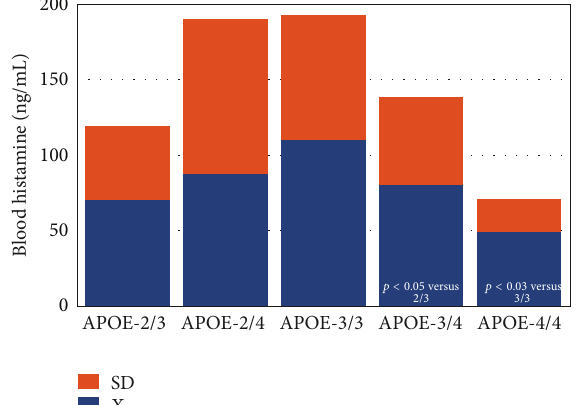
Figure 4: APOE -related blood histamine levels in Alzheimer’s dis- ease. Concentration of blood histamine in patients with Alzheimer’s disease (AD) according to their apolipoprotein-E ( APOE ) genotype. APOE distribution and frequencies: APOE -2/3: 4%; APOE -2/4: 2%; APOE -3/3: 49%; APOE -3/4: 35%; APOE -4/4: